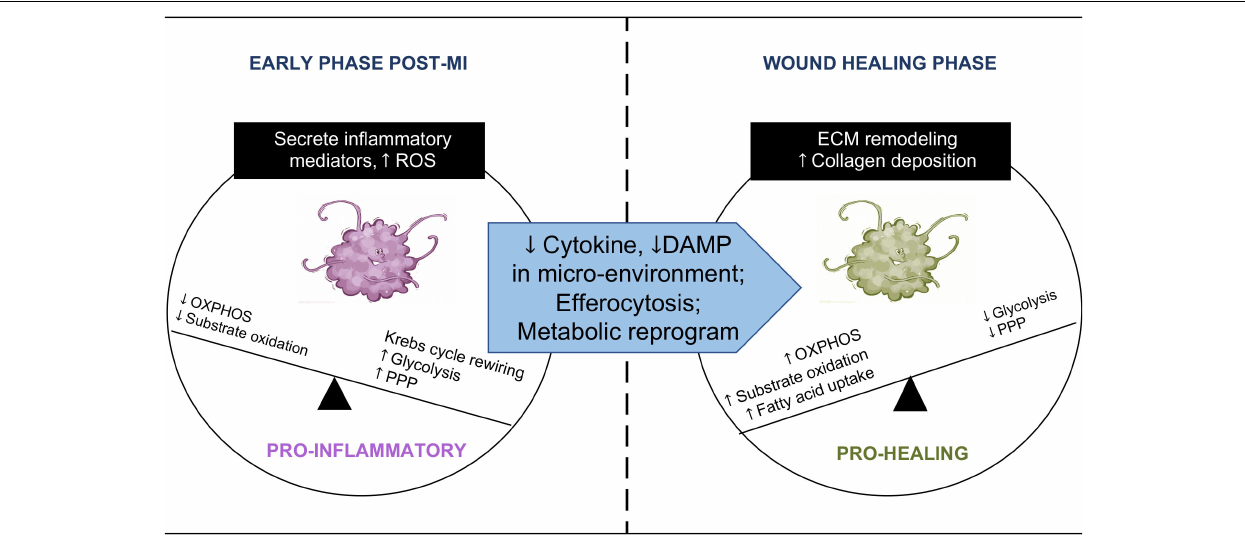
FIGURE 1 | Immunometabolic transition of macrophage post-MI. Macrophages undergo an immunometabolic transition post-MI. At the early phase, macrophages secrete pro-inflammatory cytokines in the injured myocardium. Their energy metabolism shifts toward glycolysis and increased flux through the pentose phosphate pathway (PPP), accompanied by TCA cycle rewiring and a high level of mtROS. Substrate oxidation and ATP synthesis through OXPHOS are reduced. When the infarcted region enters the wound healing phase, macrophages become phagocytotic. Changes in the microenvironment, efferocytosis, and metabolic